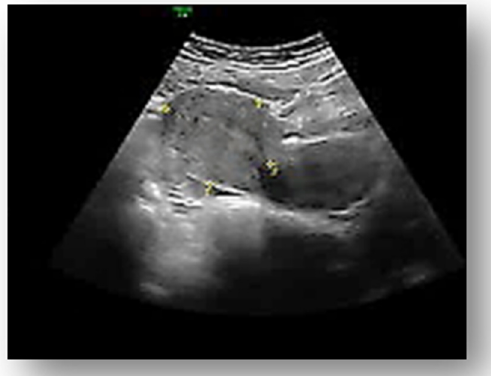
Figure 1. Transvaginal ultrasound from a 36-year-old woman with a left ectopic tubal pregnancy